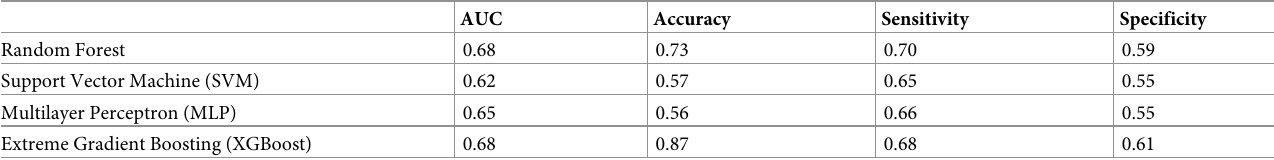
Table 3. Performance metrics of all readmission models on the testing set.